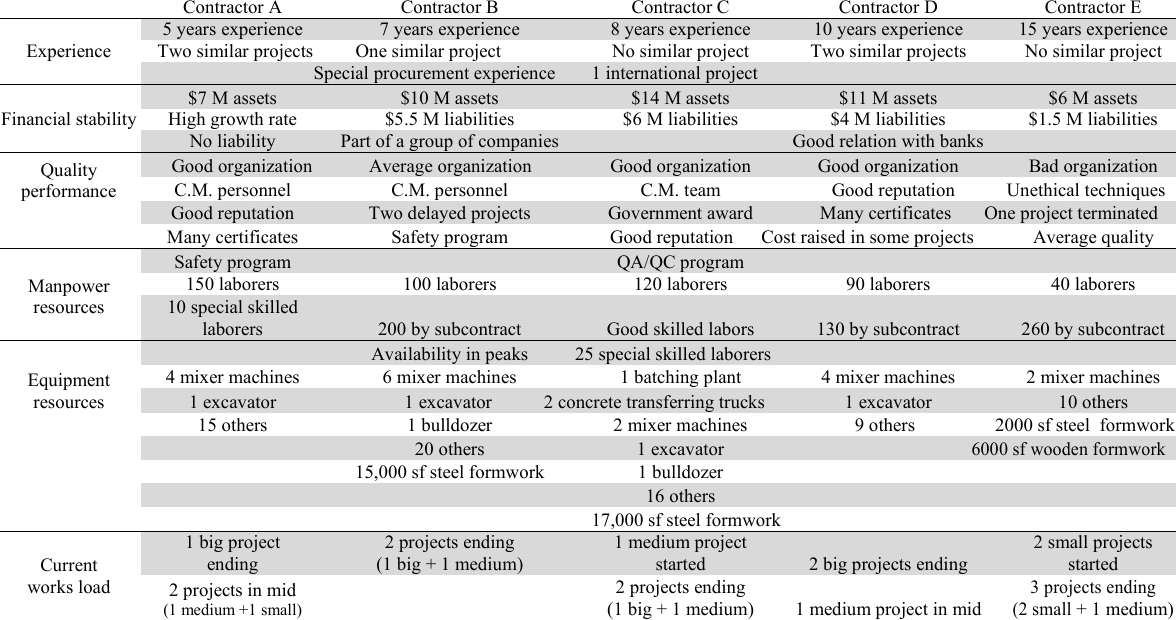
Characteristics of five